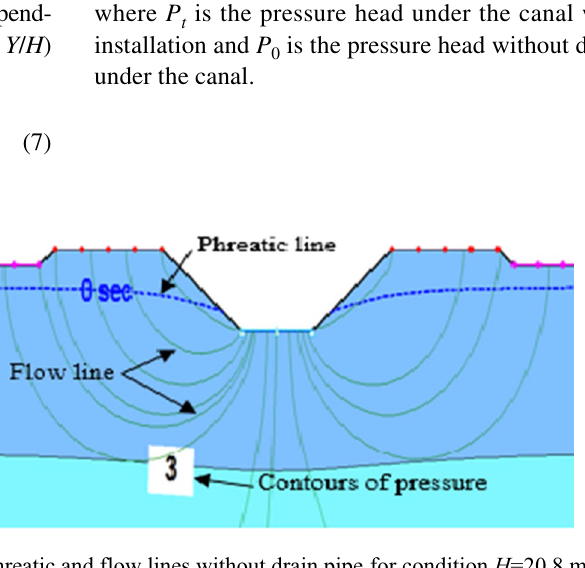
Phreatic and flow lines without drain pipe for condition H =20.8